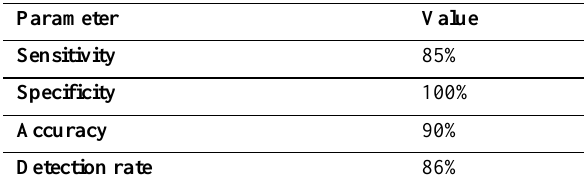
Table 4: Sensitivity, specificity and accuracy of intra- operative methylene blue dye uptake in detecting lymph node metastases